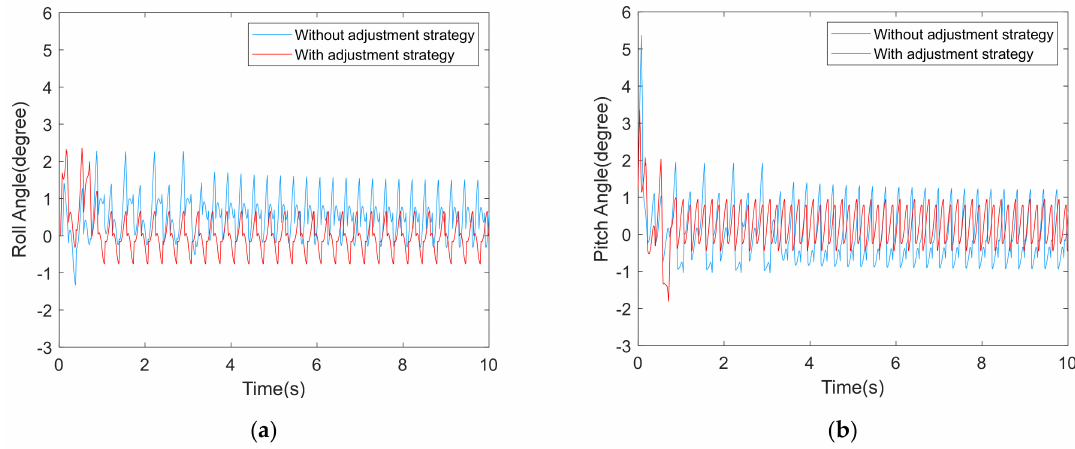
Figure 11. The quadruped robot walks on flat ground. In ( a ), the roll angle curves of the robot without and with the adjustment strategy are compared. In ( b ), the pitch angle curves of the robot without and with the adjustment strategy are